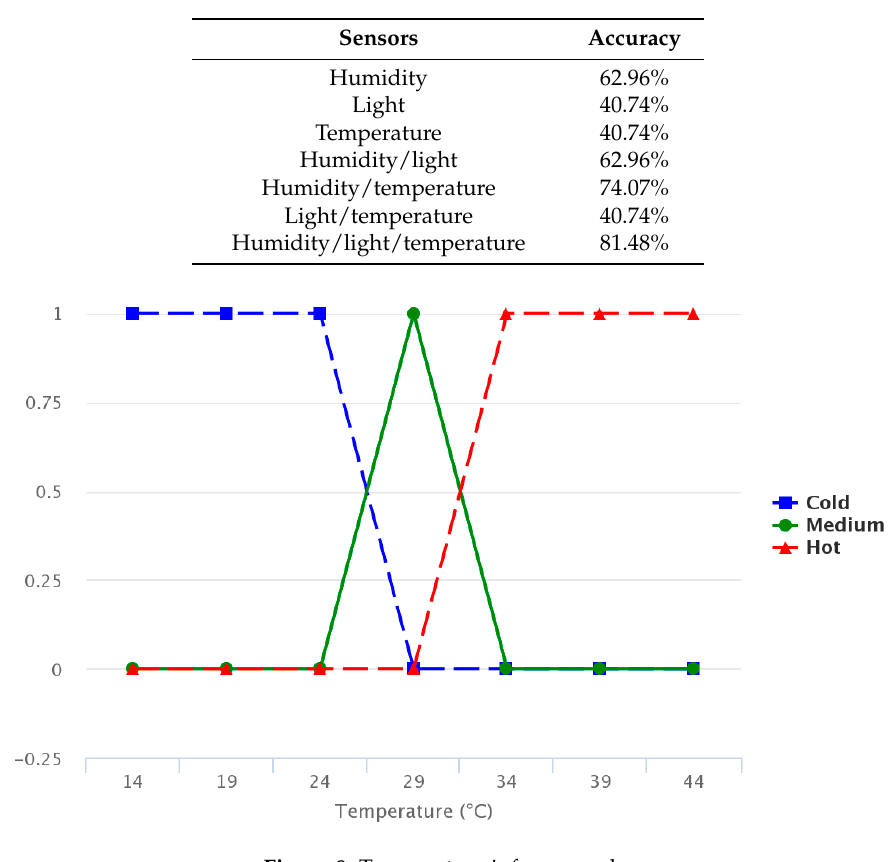
Figure 8. Temperature inference rule.